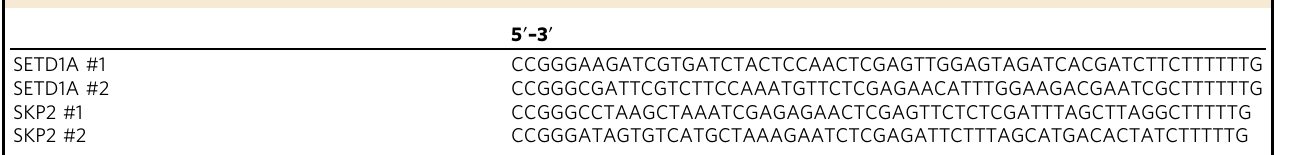
Table 2 The primer sequences used for gene expression analysis using qPCR